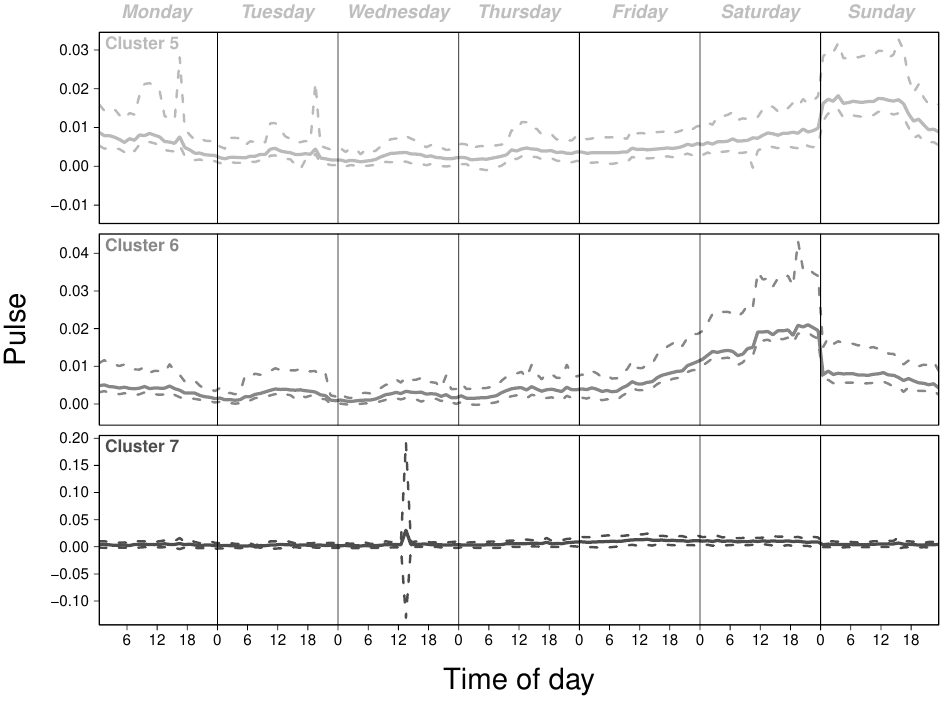
Figure A8. Pulses associated with the three additional clusters. The solid lines represent the average pulse, while the dashed lines represent one standard